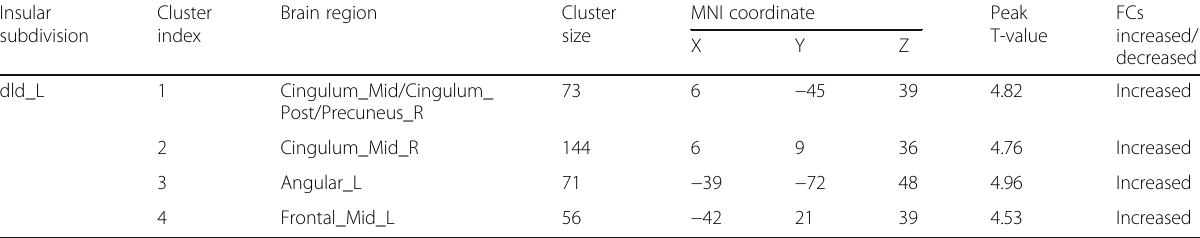
Table 4 Significant FCs between the insular subdivision and the whole brain in males Insular subdivision